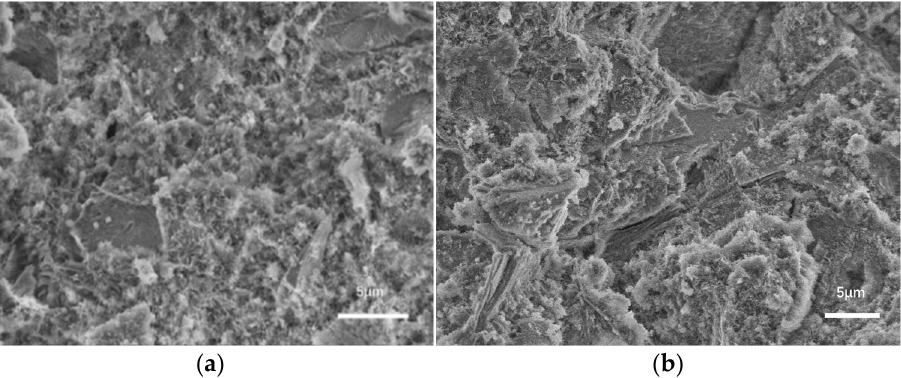
Figure 9. SEM images of cement samples. ( a ) 0% ultrafine calcium silicate; ( b ) 8% ultrafine calcium silicate.